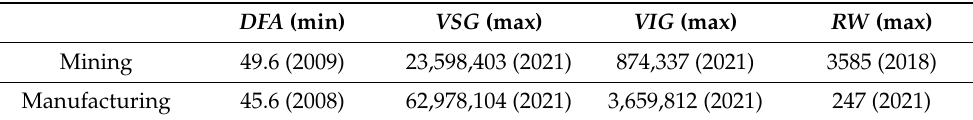
Table 3. Benchmark values the innovative industrial systems indicators.